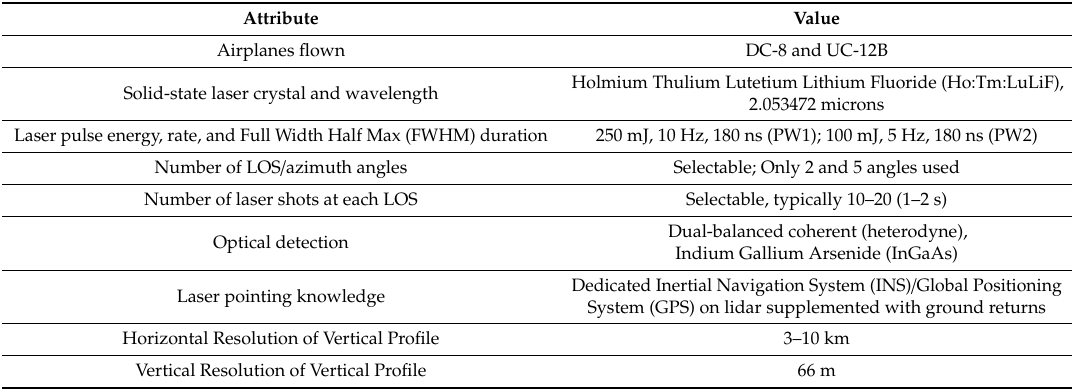
Table 4. DAWN Wind Lidar Specifications during Polar